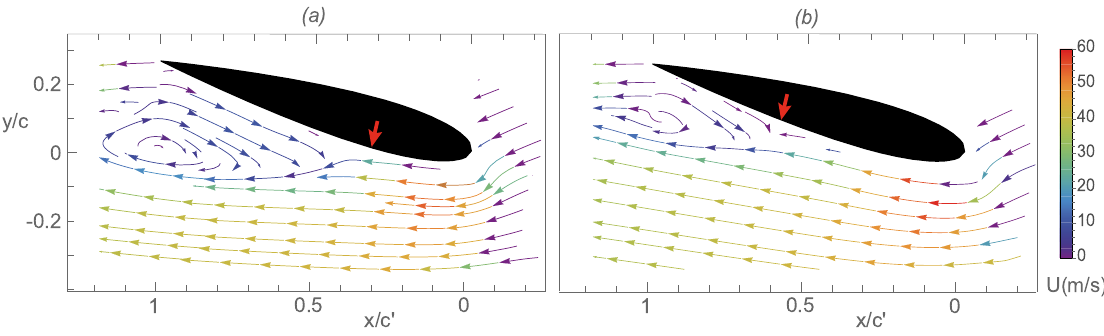
Figure 10. ( a ) Plasma-off and ( b ) plasma-on flow field at R for α = 14.5 ◦ and U ∞ = 20